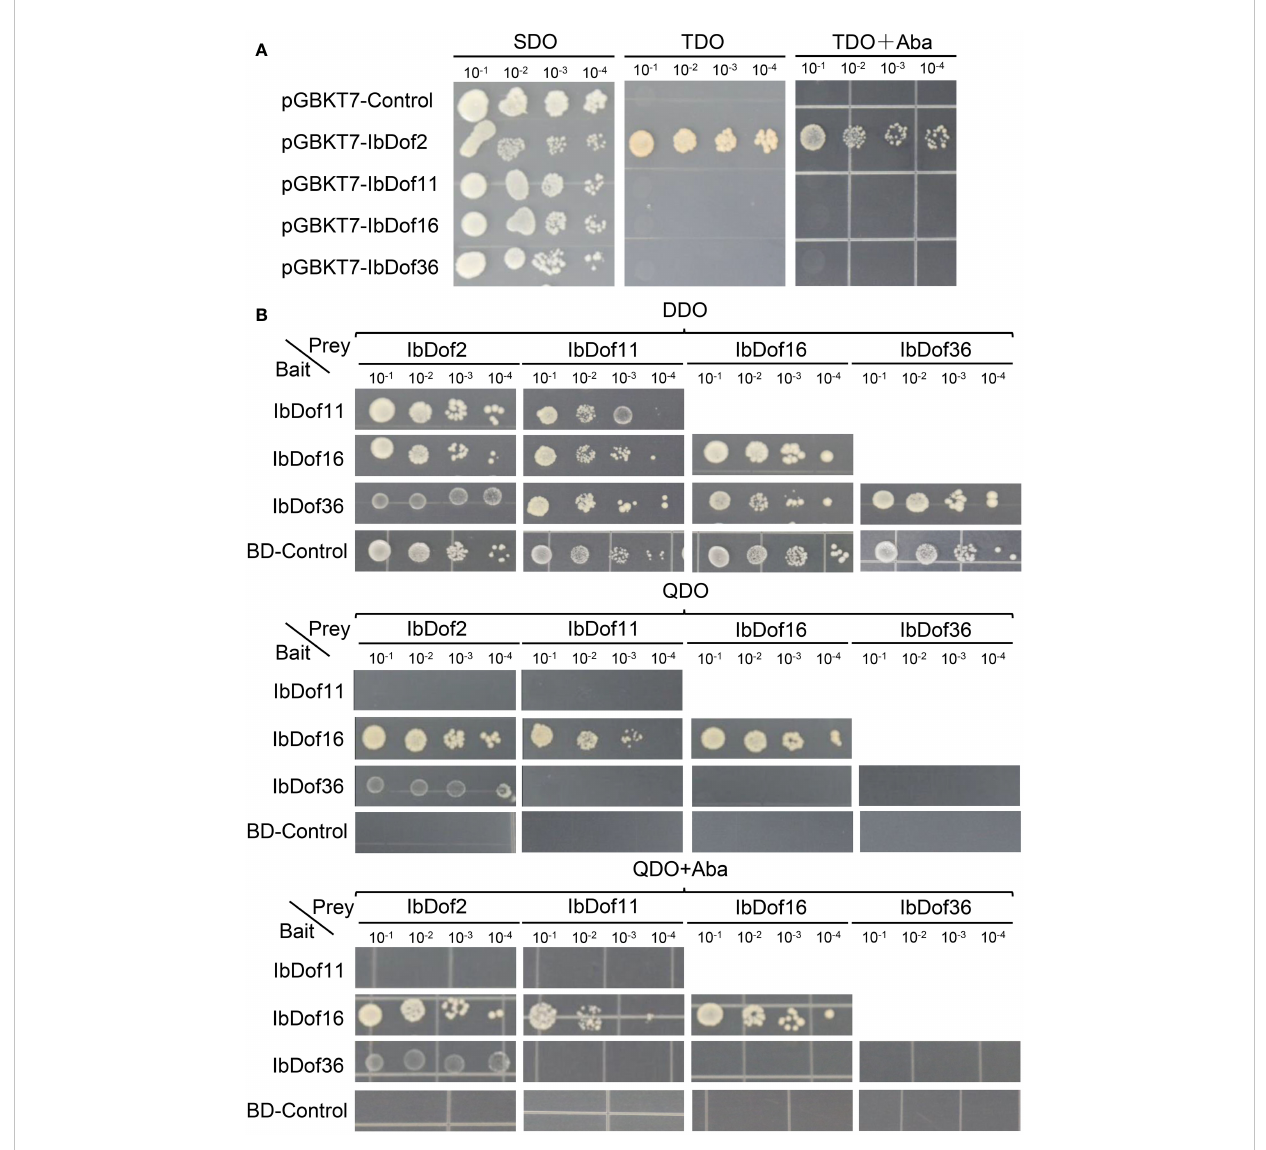
FIGURE 9 Analysis of transactivation activities and protein interactions of IbDof proteins. (A) Transactivation assays of IbDof-2/-11/-16/-36 in yeast strain Y2Hgold. Yeasts containing pGBKT7-IbDof-2/-11/-16/-36 or pGBKT7 empty vector (negative control) were streaked on the SDO (SD medium lacking Trp); TDO (SD medium lacking Trp, His, Ade) and TDO medium with 200 ng/mL AbA, respectively. (B) Yeasts containing both the indicated recombined pGBKT7 and pGADT7 plasmids were streaked on DDO (SD/-Trp-Leu) medium, QDO (SD/-Trp-Leu-His-Ade) medium with or without 200 ng/mL AbA. All the plates were recorded three days after 30° of